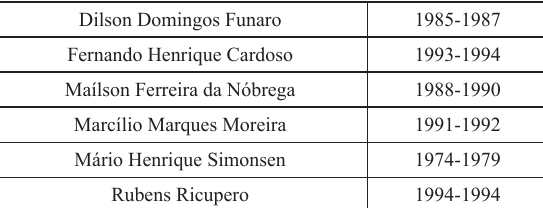
Brazilian Treasury Ministers with no academic formation in Economics who have achieved significant public